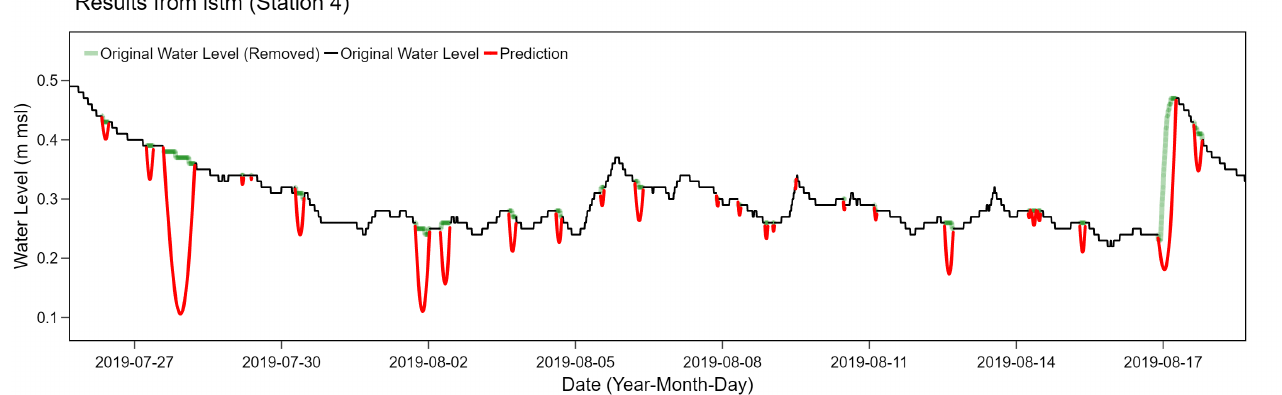
Figure 13. Results from bidirectional LSTM filling method for station